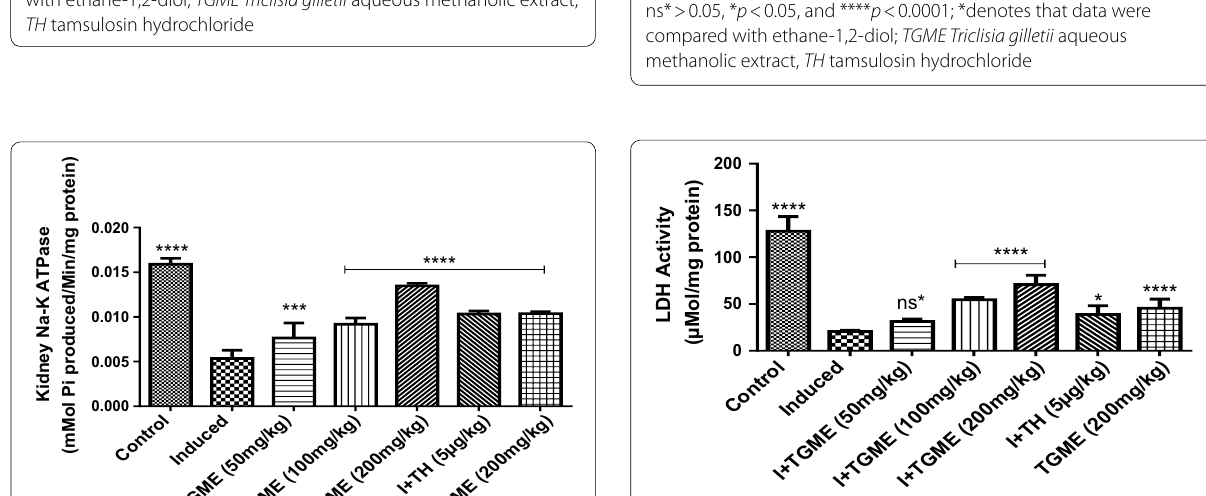
SEM of 6 rats ( n 6); ± =